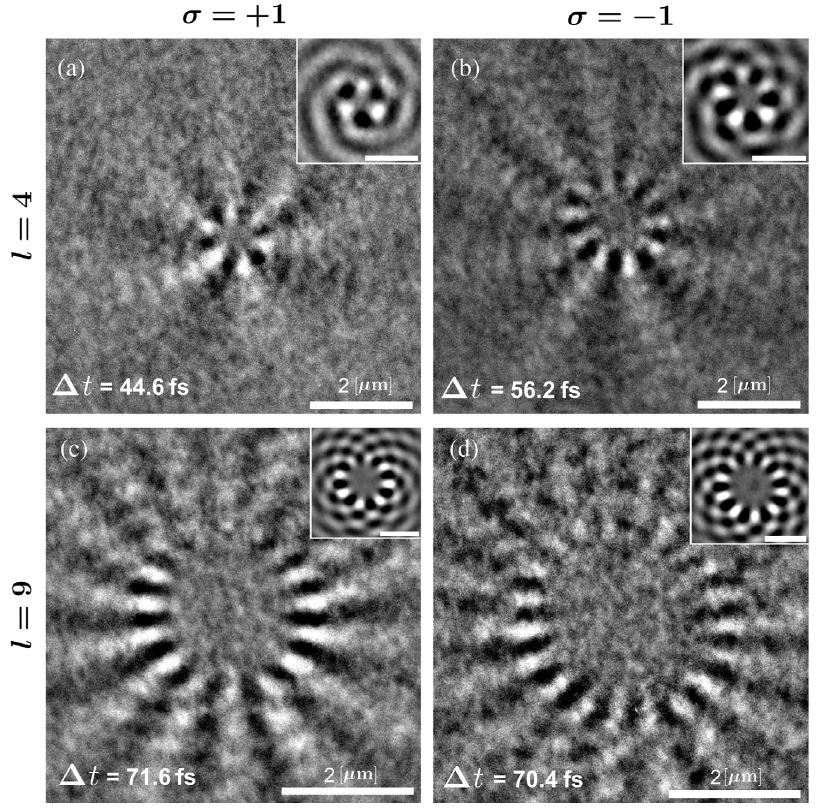
FIG. 4. Experimental results of second-order photon-plasmon AM mixing. We show the filtered raw experimental data for oscillations of 2 ω Δ t . The results clearly show azimuthal patterns of order l same raw data filtered for oscillations of ω Δ t with azimuthal patterns of order l